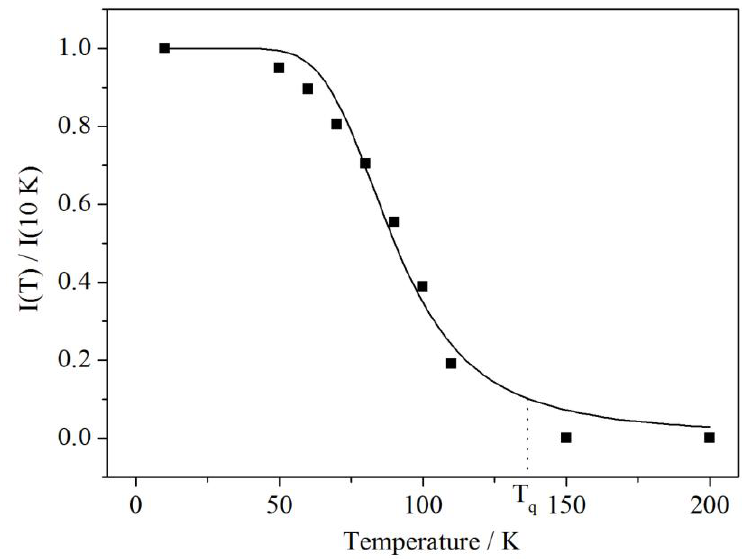
SiO :Sr 2+ . The black curve was fitted according to 2 4 = 50 meV or 400 cm −1 a